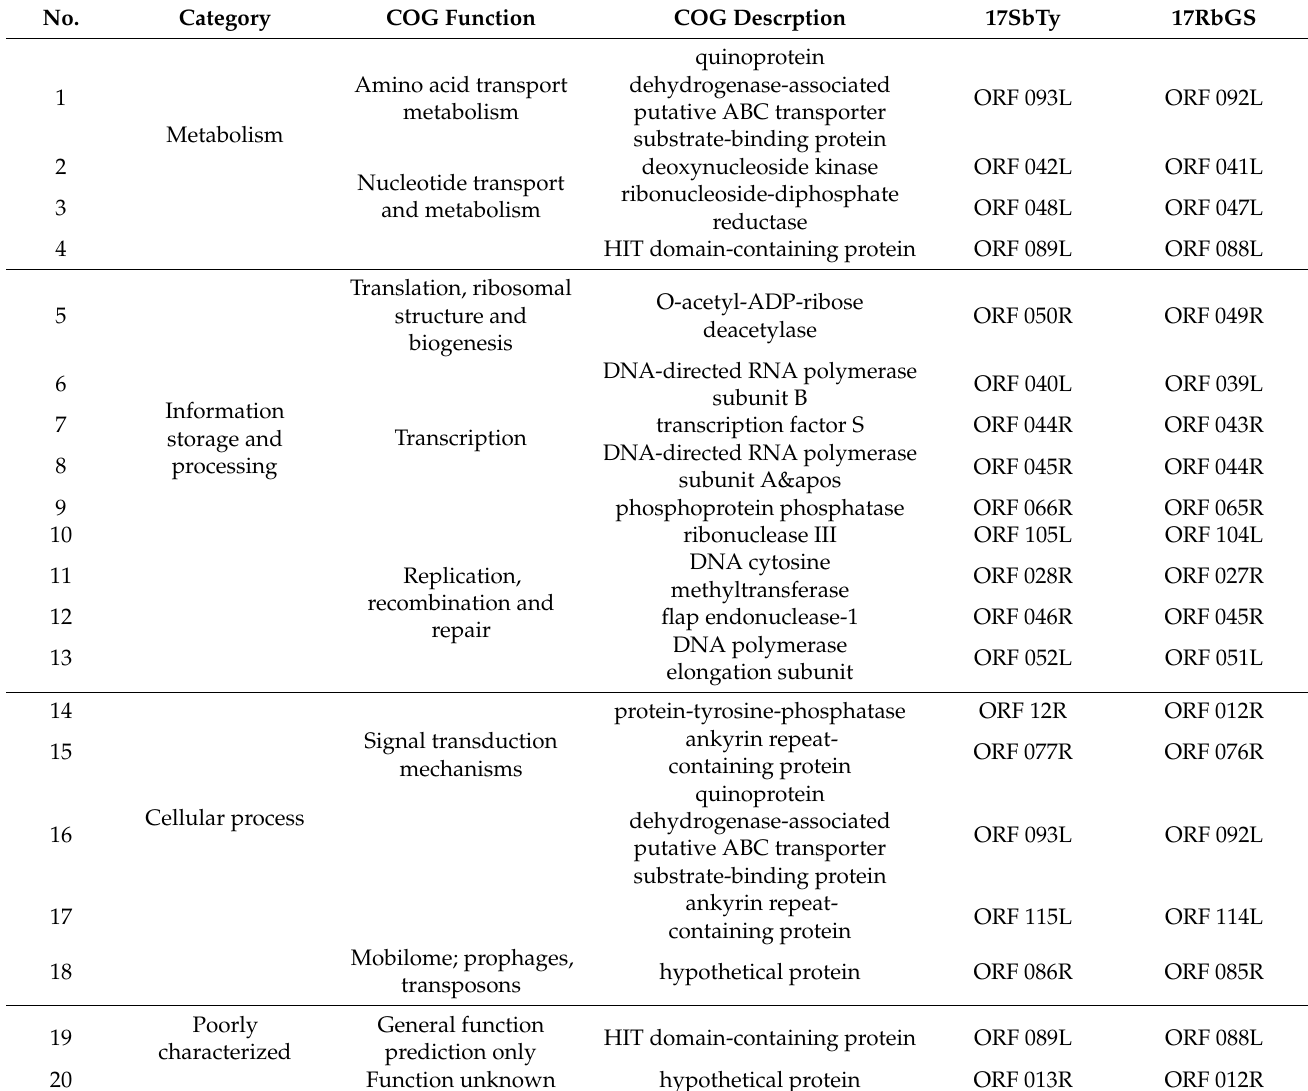
Table A3. The coding sequences (CDSs) determined via COG classification of 17SbTy and 17RbGs in four functional cate-